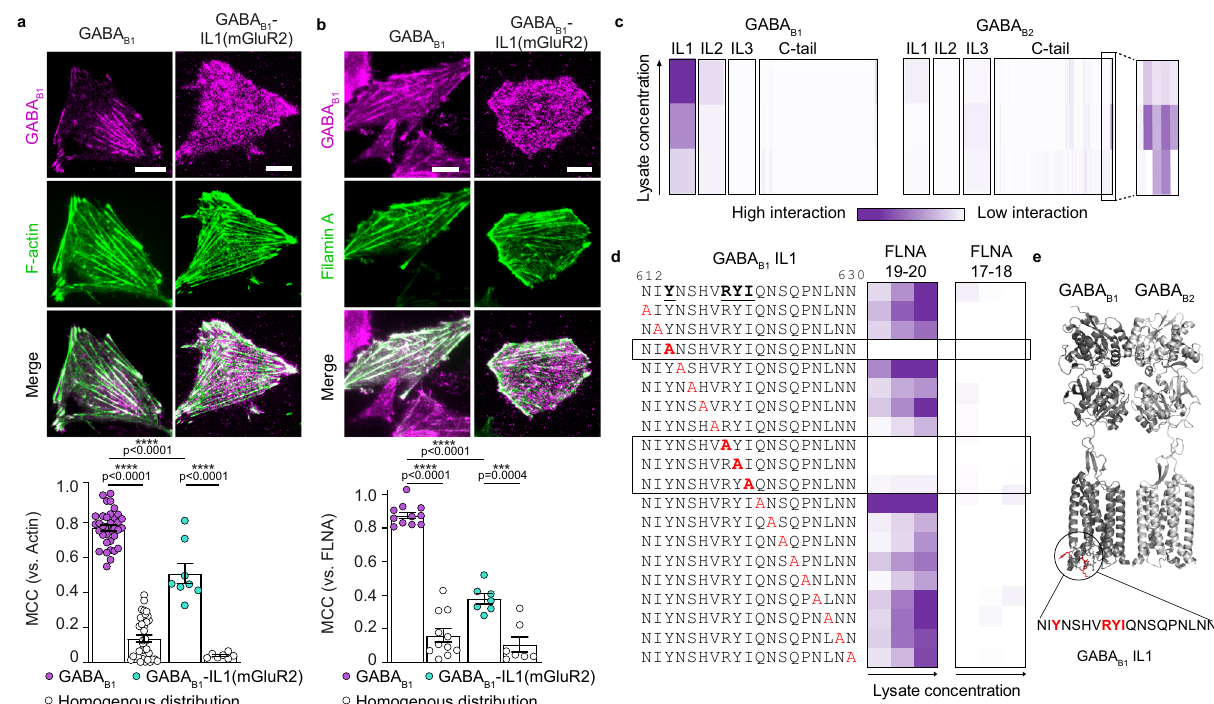
Fig. 3 | A linear motif in the IL1 of GABA B1 binds FLNA to mediate interaction with the actin cytoskeleton. a Top, representative TIRF images of SNAP-GABA B1 (left) or SNAP-GABA B1 -IL1(mGluR2) (right) labeled with SNAP-647 in CHO cells additionally co-transfected with GABA B2 and Lifeact-GFP. Bottom, corresponding MCC analyses. Data are mean±SEM. n =35 and n =8 (GABA B1 and GABA B1 -IL1(m- GluR2), respectively) examined over three independent experiments. b Top, representative TIRF images of SNAP-GABA B1 (left) or SNAP-GABA B1 -IL1(mGluR2) (right) labeled with SNAP-647 in CHO cells co-transfected with GABA B2 and eGFP- FLNA. Bottom, corresponding MCC analyses. Data are mean±SEM. n =11 and n =7 (GABA B1 and GABA B1 -IL1(mGluR2), respectively) examined over two independent experiments. c , Peptide microarray results. Peptide microarrays encompassing